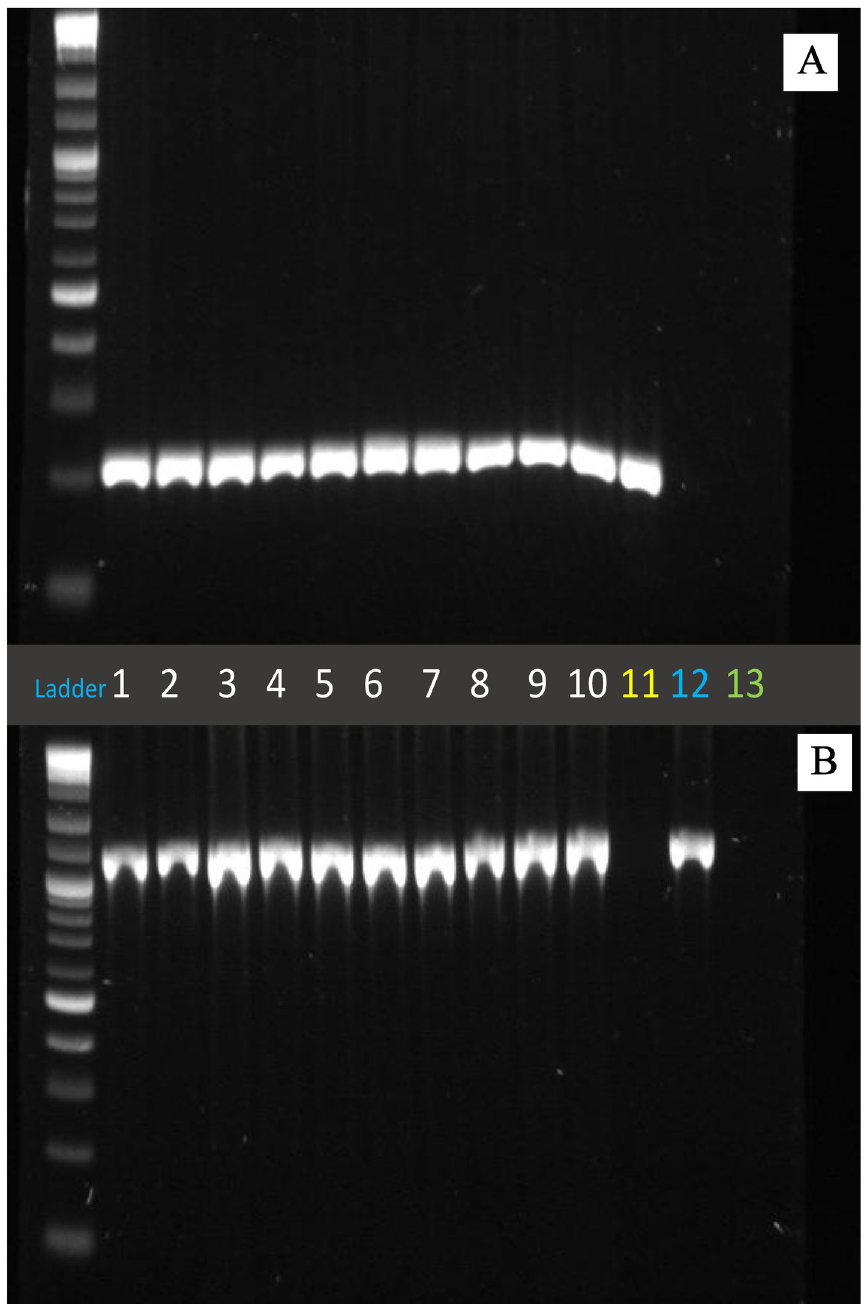
Fig 4. Gel picture showing the result of colony PCR of 10 recombinant colonies picked. A. the result of colony PCR using Kanamycin marker specific primers (Kan_in_f and Kan_in_r). B. the result of colony PCR using Chloramphenicol marker-specific primers (Cat_in_f and Cat_in_r). DNA templates used: Lane 1 to 10- recombinant colonies picked from MH agar plate having kanamycin and chloramphenicol after the recombination assay; Lane 11- parent strain with kanamycin resistance marker; Lane 12- parent strain with chloramphenicol resistance marker; Lane 13- wild-type C . jejuni strain 11168 with no marker.